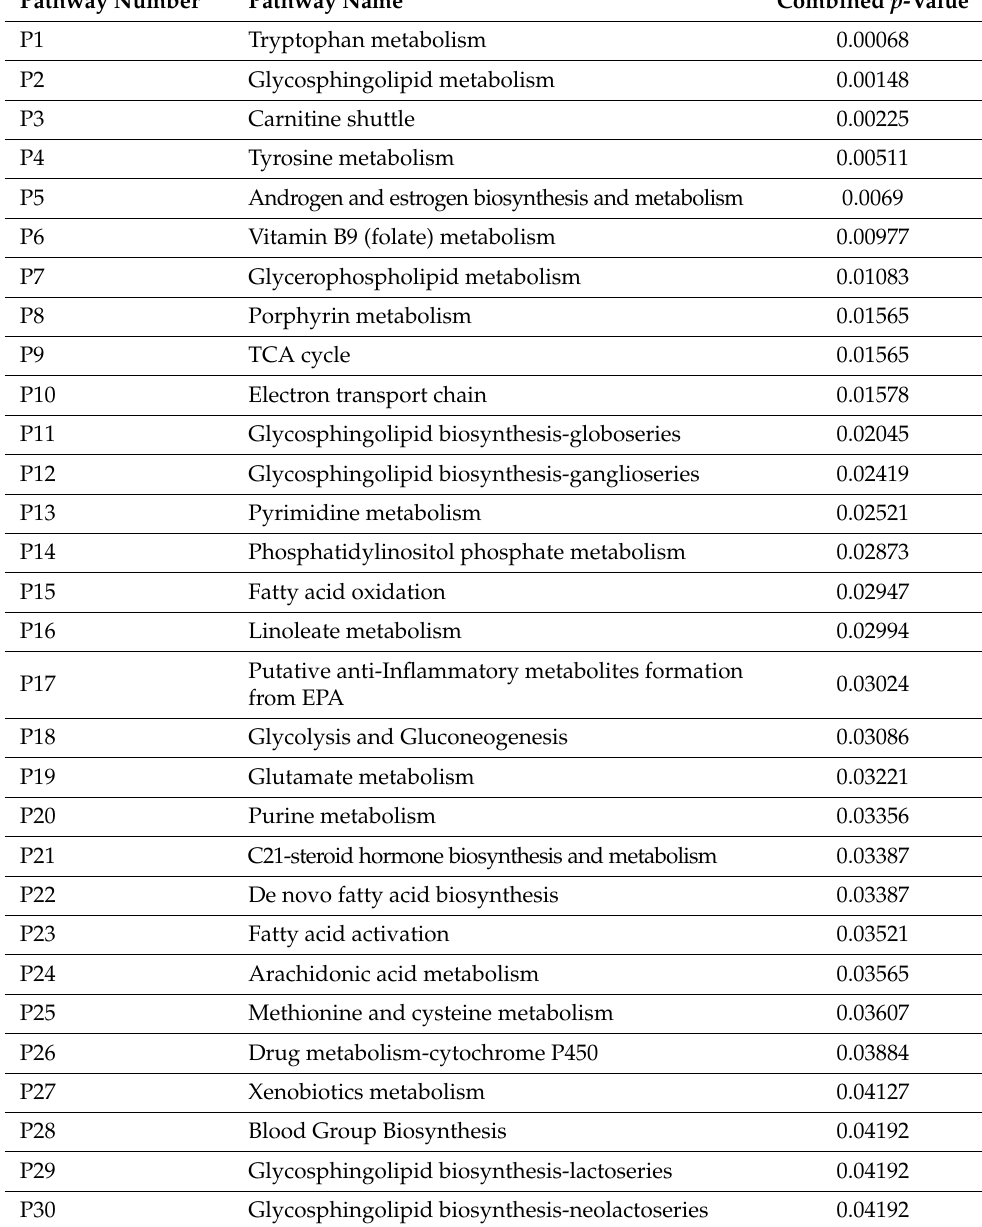
Table 7. Significantly perturbed metabolic pathways that differentiated NNK and vehicle-treated CAL27